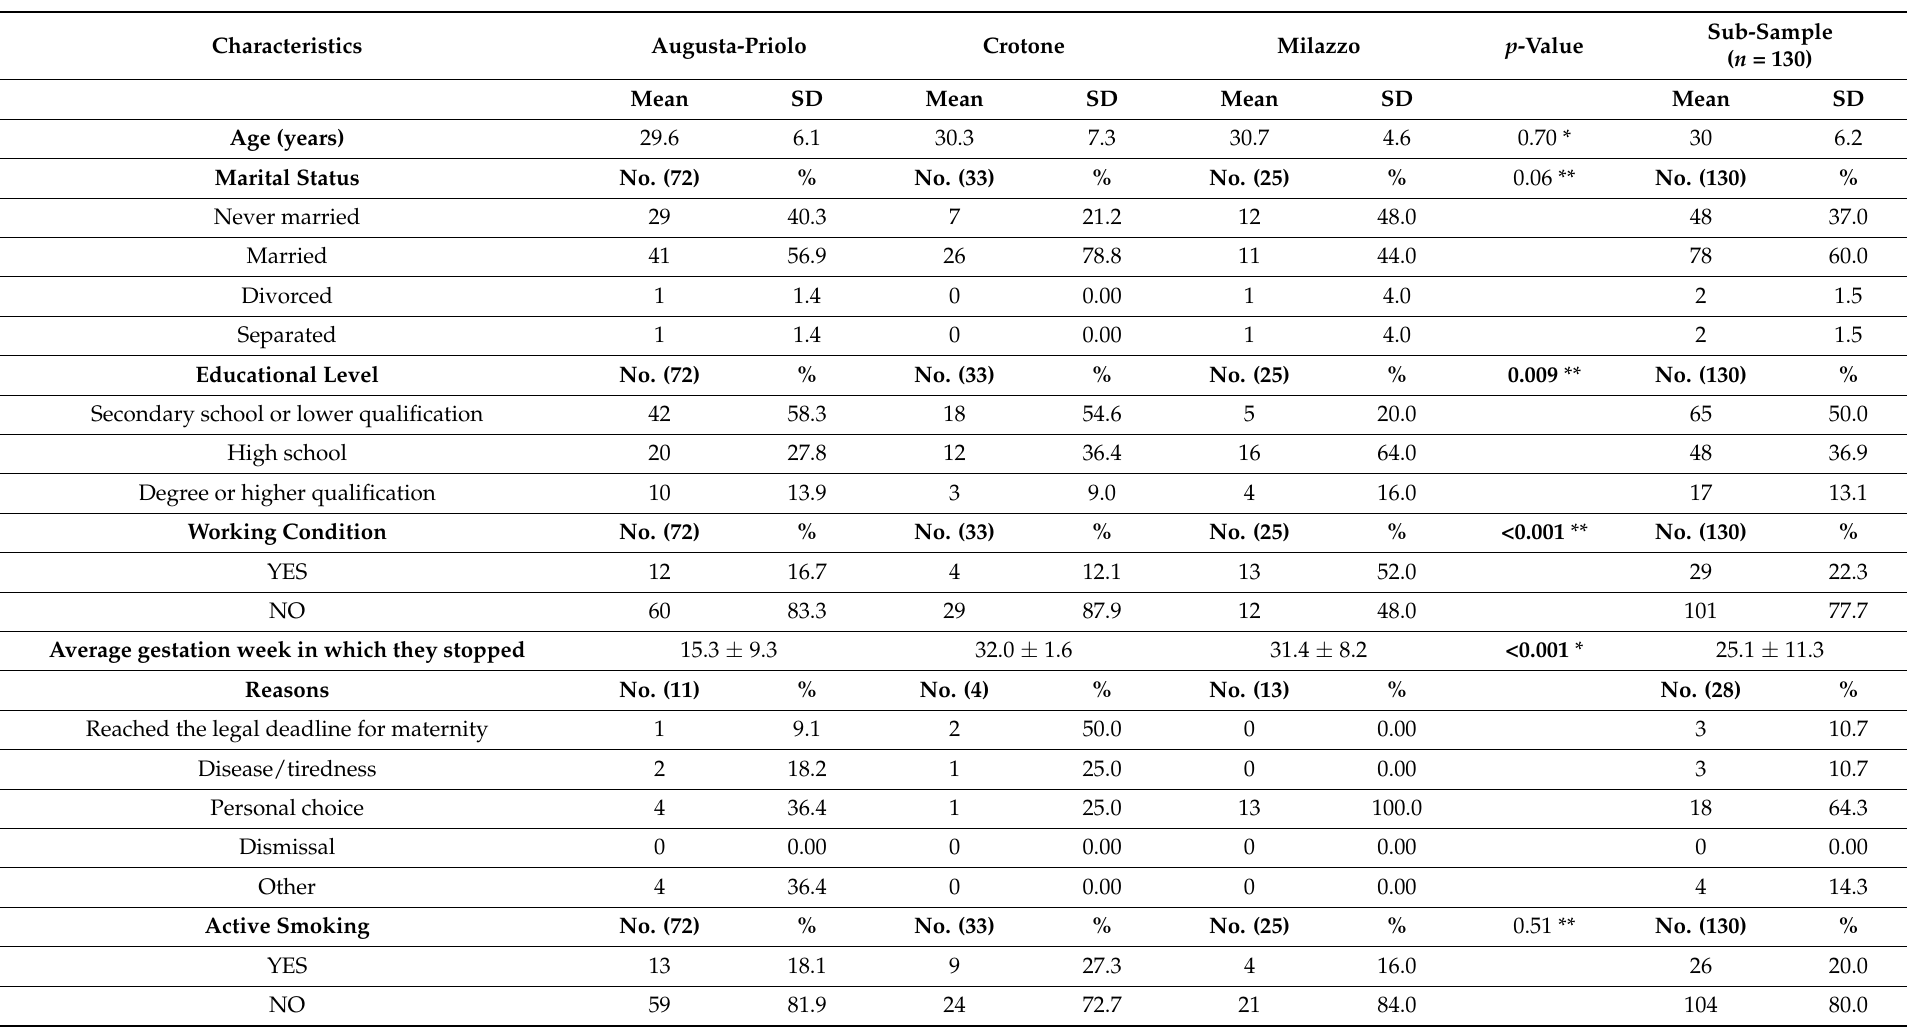
Table 4. Characteristics of the dropout mothers in the total subsample and in each NPCS: continuous variables are reported as mean ± SD, while categorical variables are reported as numbers and percentages. Significant p -values are in bold. For each categorical variable, in parentheses, the total number of responders is